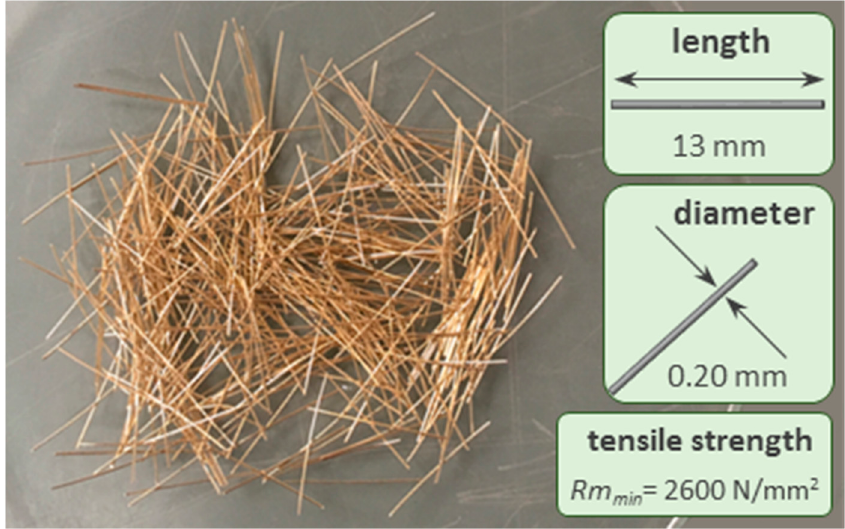
Figure 2. Grading Dramix-OL steel fiber characteristics.